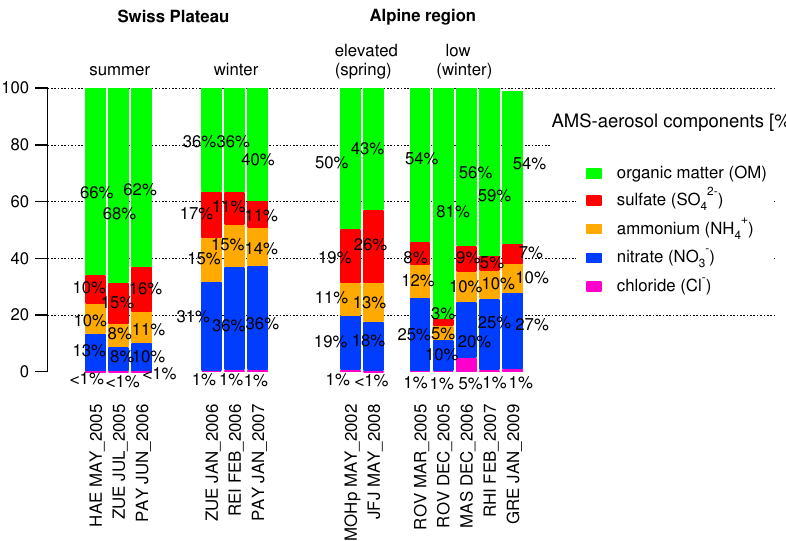
Fig. 2. Relative composition of non-refractory submicron aerosols (NR-PM 1 ) in Central Europe measured by aerosol mass spectrometers (AMS): organic matter (OM), sulfate (SO 2 − means (%) reported here is typically about 1% or